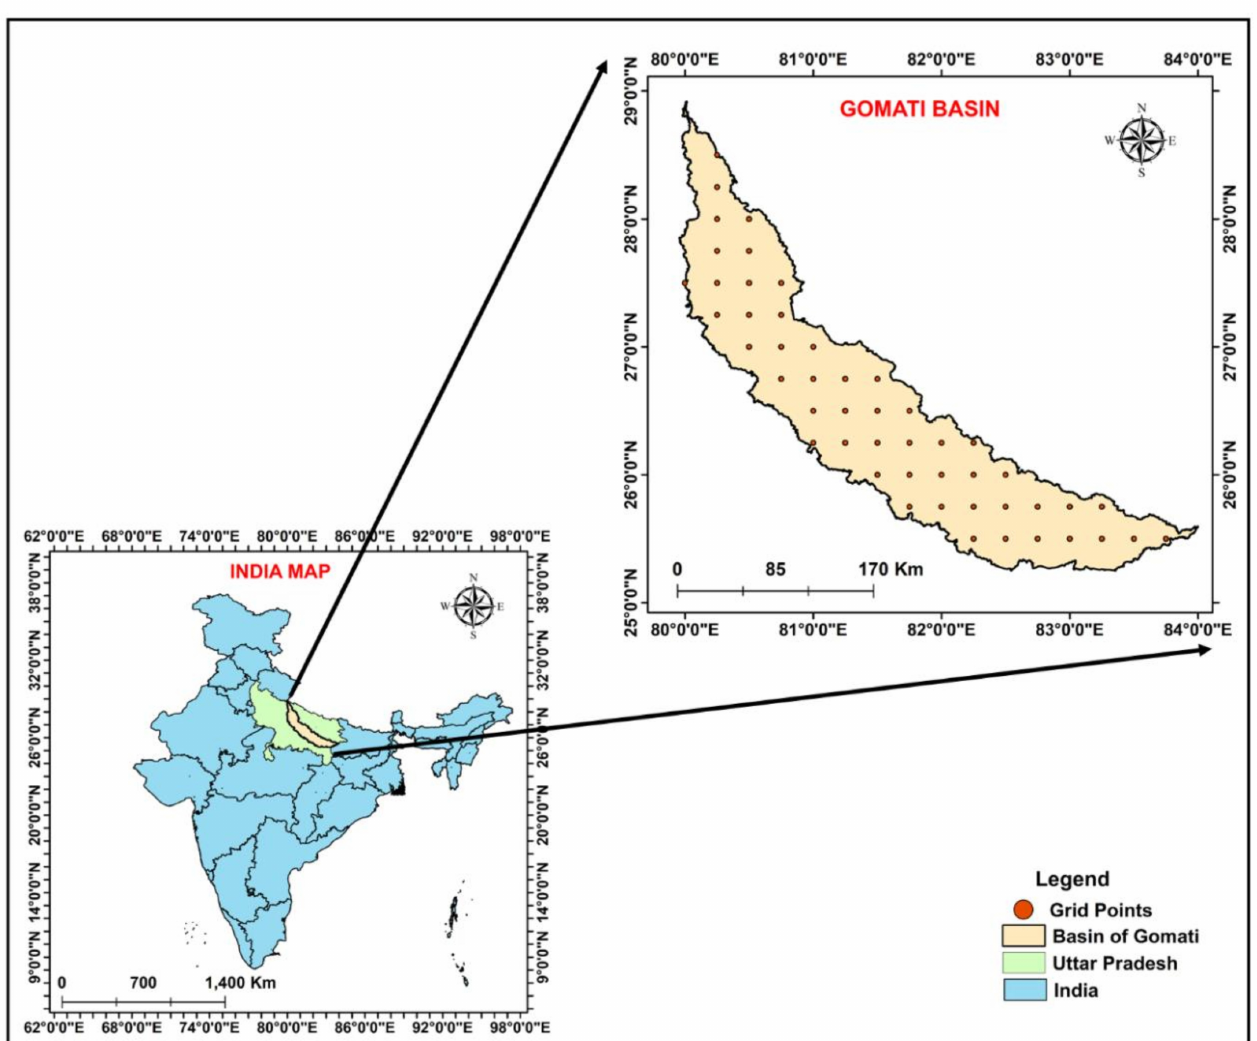
Figure 1. Indian map showing the Uttar Pradesh state and the Gomati river basin boundary in the green and orange color, respectively. Dots in the Gomati river basin show selected precipitation grid